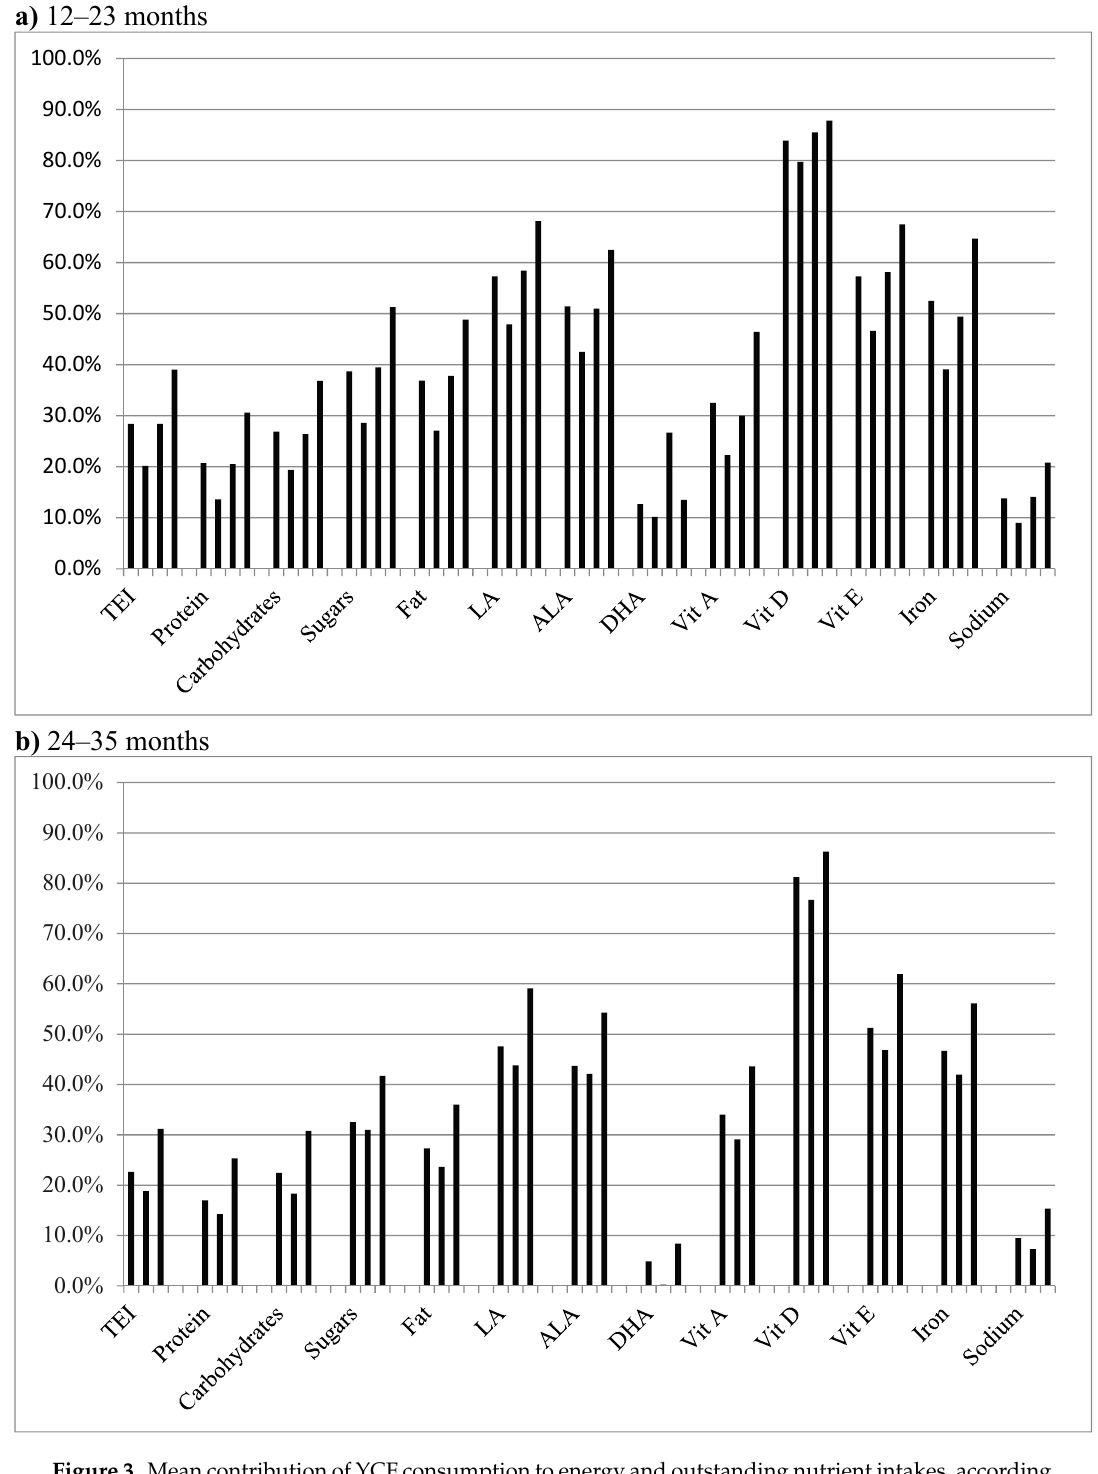
Figure 3. Mean contribution of YCF consumption to energy and outstanding nutrient intakes, according to age group and volume of YCF consumption: ( a ) age group 12–23 months. For each nutrient the vertical bars concern, in order, the total population of the age group, infants consuming 240–360 mL/d, infants consuming 360–480 mL/d, and those consuming 480 mL/d or more; ( b ) age group 24–35 months. For each nutrient the vertical bars concern, in order, the total population of the age group, infants consuming 240–360 mL/d, and those consuming 360 mL/d or more. Sugars: monosaccharides and disaccharides; ALA: α -linolenic acid; DHA: docosahexaenoic acid; LA: linoleic acid; TEI: Total Energy